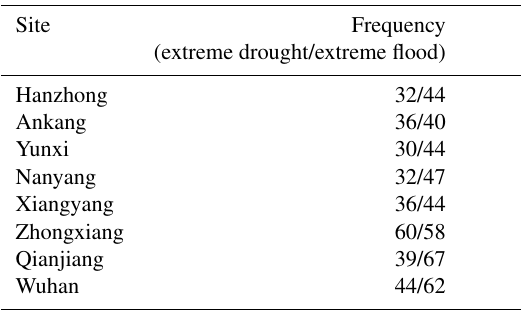
Table 4. The counts of extreme (grade 5) droughts and extreme (grade 1) floods at each site in the HRB during